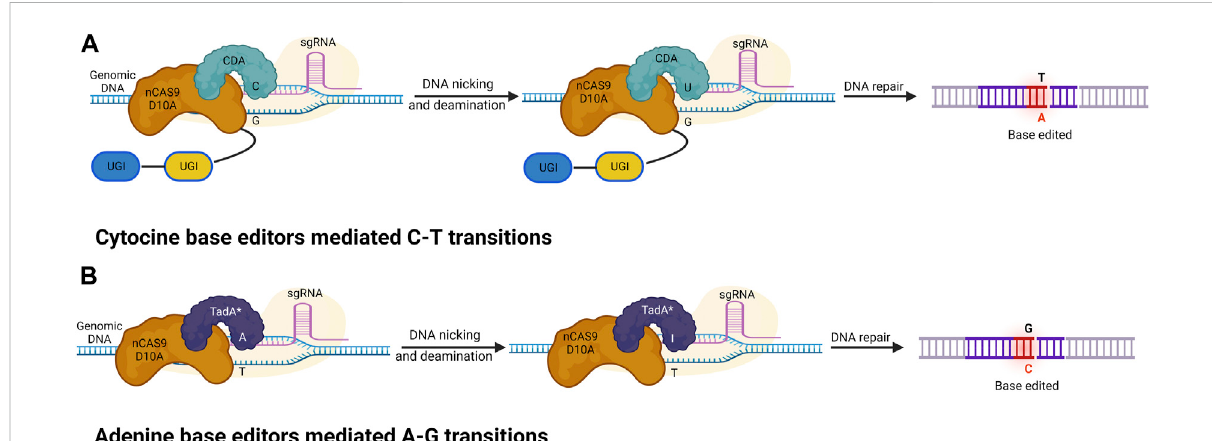
FIGURE 3 Cytosine and adenine base editors. (A) Cytosine base editors (CBEs), composed of a nickase Cas9 (nCas9) fused to a deaminase and UGI; conversion of C-G into T-A base pairs. (B) Adenine base editors (ABEs) are composed of a dead (d) or nickase (n) Cas9 (d/nCas9) fused to two TadA, with one evolved to edit adenine in DNA (TadA*) and one wild type (TadA). ABEs convert A-T into G-C base